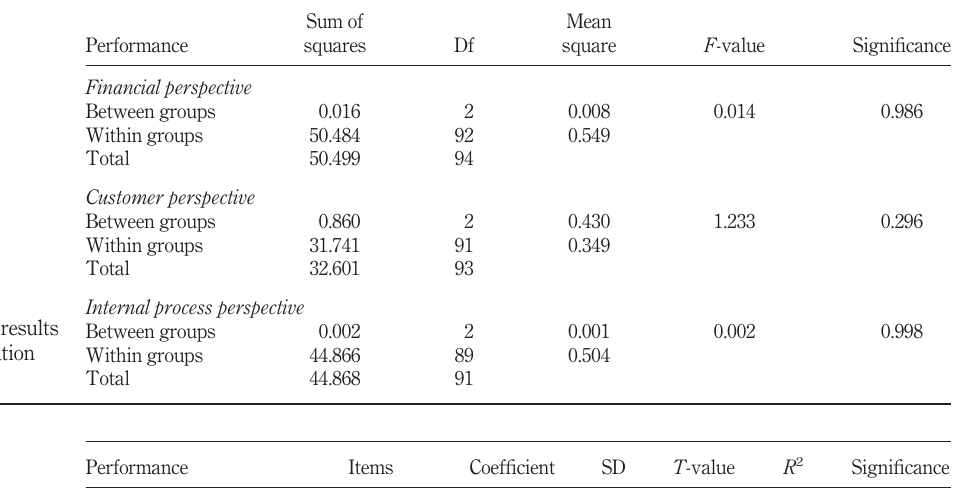
Table VII. Correlation between consulting/ customization costs and ERP